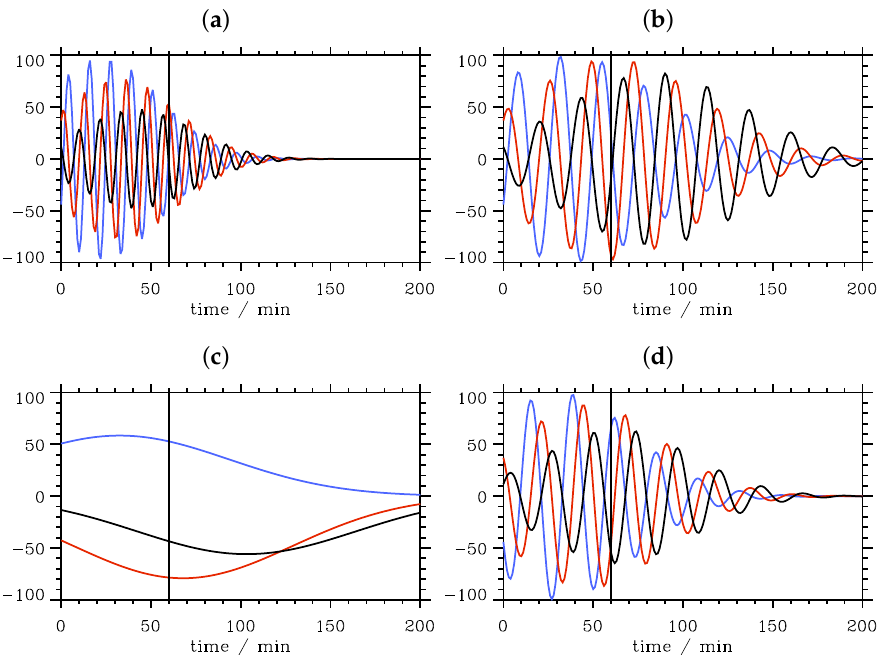
Figure 9. Time series of the vertical displacements ξ ( x , z , t ) of horizontally- and vertically-propagating wave packets with the wavenumber vector (cid:126) k D recorded at the three positions as marked by colored crosses in Figure 7. The wave frequencies are Doppler shifted by U = + c Px ( a ), U = 0 ( b ), U = − c Px ( c ) and U = − 2 c Px ( d ), respectively. The vertical black lines refer to the time t = 60min where the altitude-distance plots are shown in Figure